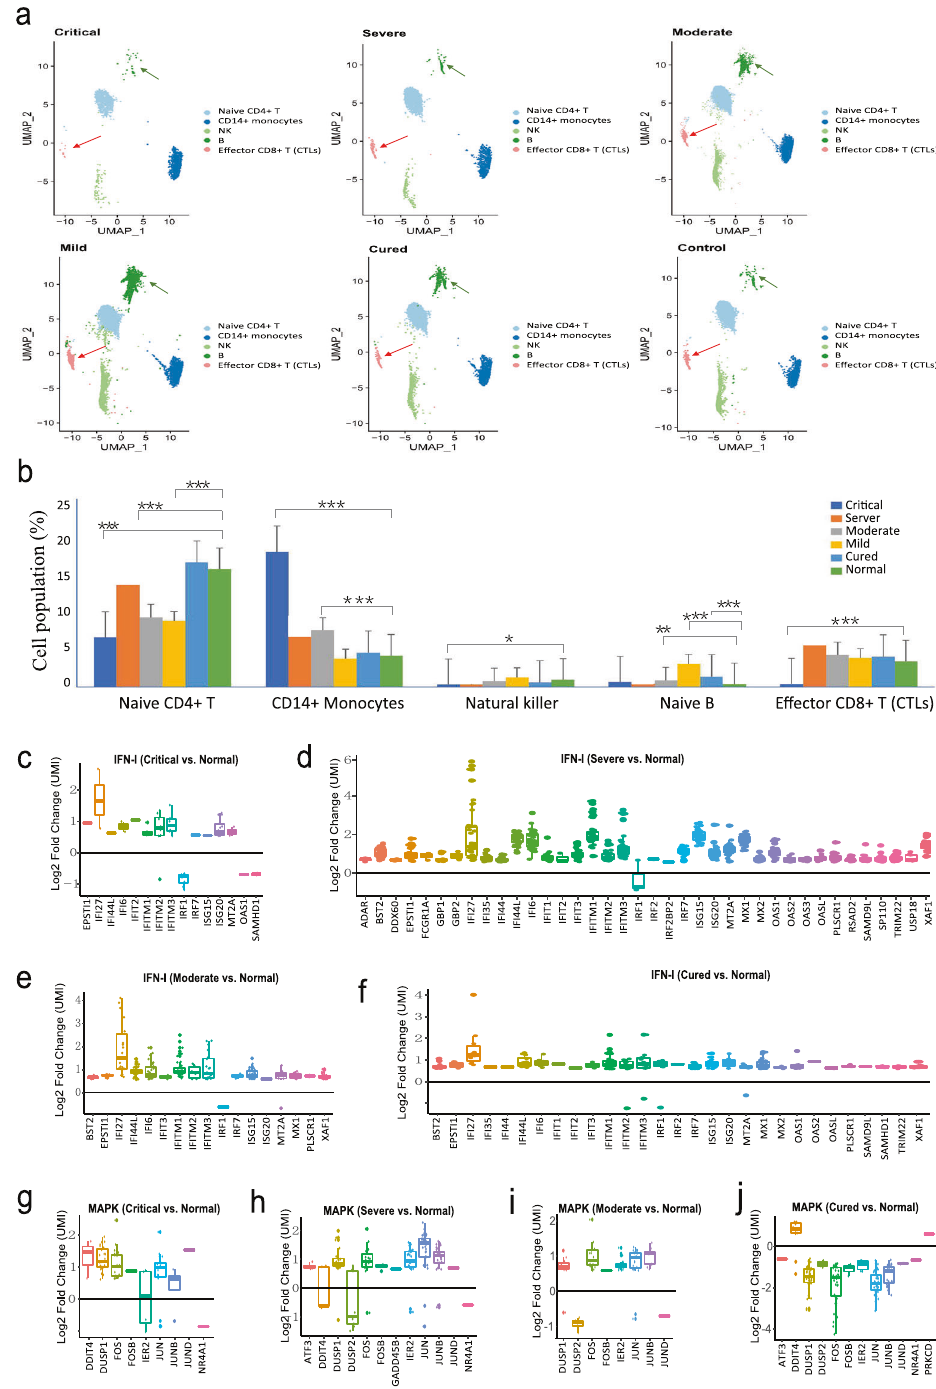
Fig. 2 UMAP projection of fi ve cell clusters and Gene expression changes of IFN-I and MAPK pathway in response to SARS-CoV-2 infection. a UMAP projection of fi ve cell clusters among critical ( n = 2), severe ( n = 1), moderate ( n = 6), mild ( n = 3), cured ( n = 4), and controls ( n = 3). naive CD4 + T: cluster 1 in Fig. 1d; CD14 + monocytes: cluster 10 in Fig. 1d; NKs: cluster 13 in Fig. 1d; B cells: cluster 19 in Fig. 1d; terminal CD8 + effector T: cluster 24 in Fig. 1d. The red arrow in a indicated the effector CD8 + T (CTLs), the green arrow in a indicated the B cells. They are signi fi cantly changed comparing to COVID-19 patients and controls. The related section is explained in the bottom of Page 7 of the main text. b Statistical signi fi cance (each of the other conditions vs. controls) for the cell population mentioned in a . * p < 0.05; ** p < 0.01; *** p < 0.001. c – f Log2 fold changes of the unique molecular identi fi ers (UMI) counts of IFN-I pathway genes comparing patients to normal controls. c The critical patients (patient 1 and patient 2) vs. normal controls. d The severe patient (patient 3) vs. normal controls. e The moderate patients (patients 4 – 9) vs. normal controls, and f The cured patients (patients 11 and 10) vs. normal controls. g – j Log2 fold changes of the UMI counts of MAPK targets in critical ( g ), severe ( h ), moderate ( i ), and cured patients with COVID-19 vs. normal controls ( j ), respectively. Each point represents a different cell subtype